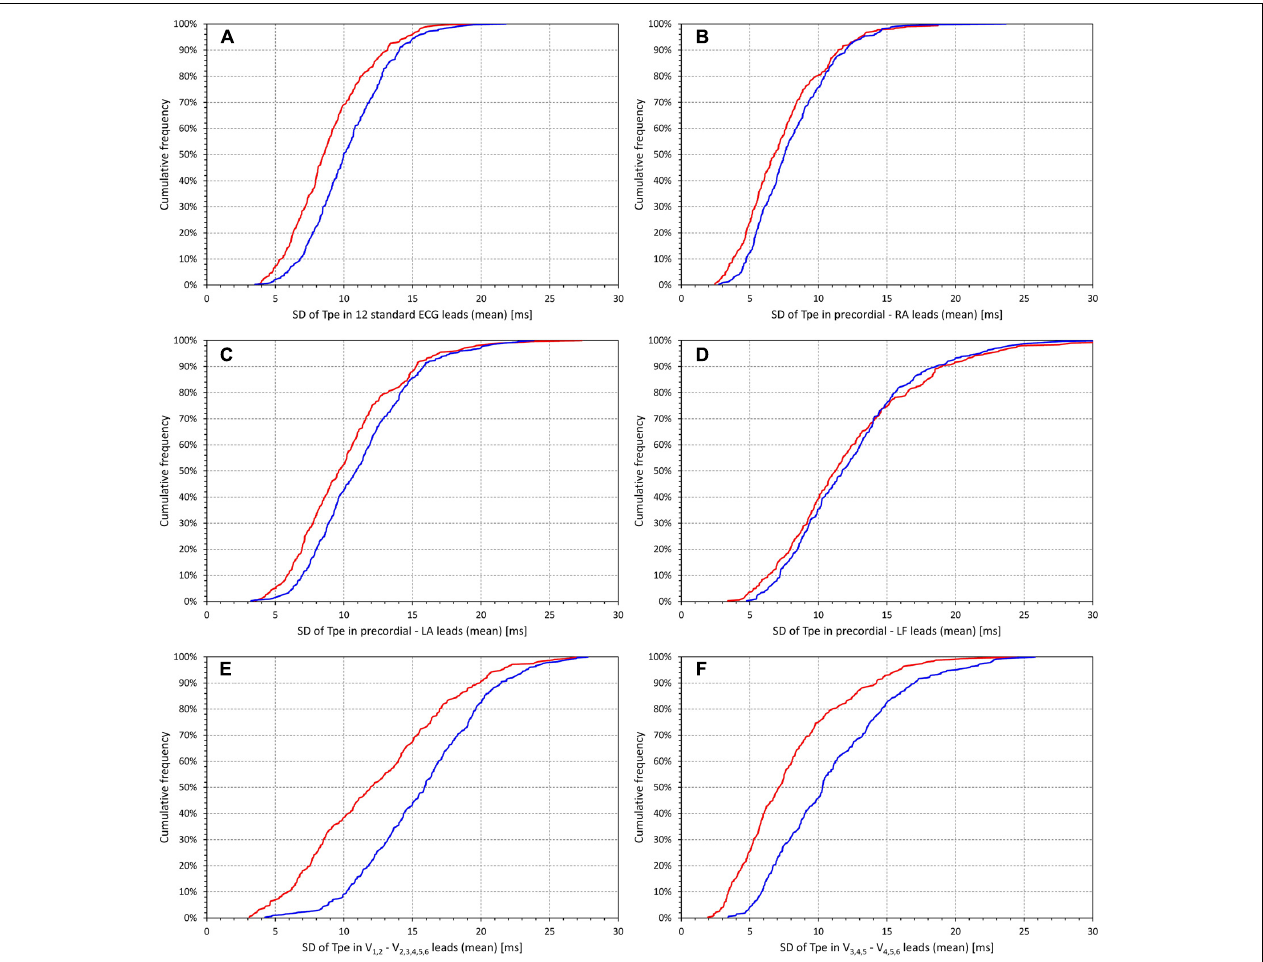
FIGURE 4 | Cumulative distributions of the standard deviations of the Tpe intervals in groups of electrocardiogram (ECG) leads (mean values in individual subjects). Different panels of the figure correspond to different groups of ECG leads—the association of the panels with the lead groups is the same as in Figure 1 . In each panel [please see the labels of horizontal axes for the explanation of panels (A–F) ], the red and blue lines correspond to the distributions in female and male subjects, respectively. SD, standard deviation; RA, right arm; LA, left arm; LF, left